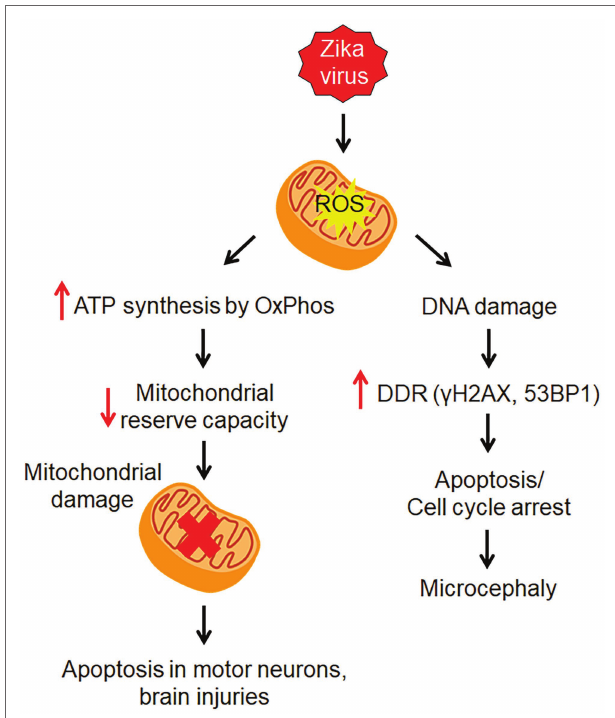
FIGURE 2 | Zika virus-induced mitochondrial stress. ZIKV infection causes mitochondrial stress by altering its structure and metabolism to supply energy for viral replication through oxidative phosphorylation (OxPhos) pathway. This leads to an increase in reactive oxygen species (ROS) which causes DNA damage. Then the DNA damage response (DDR) is induced to activate repair pathways to monitor DNA